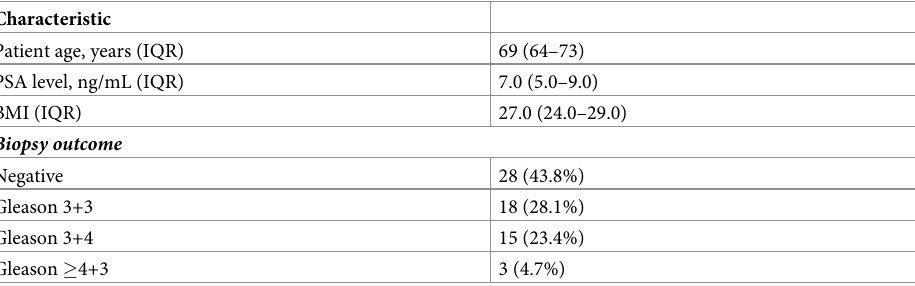
Table 2. Patient